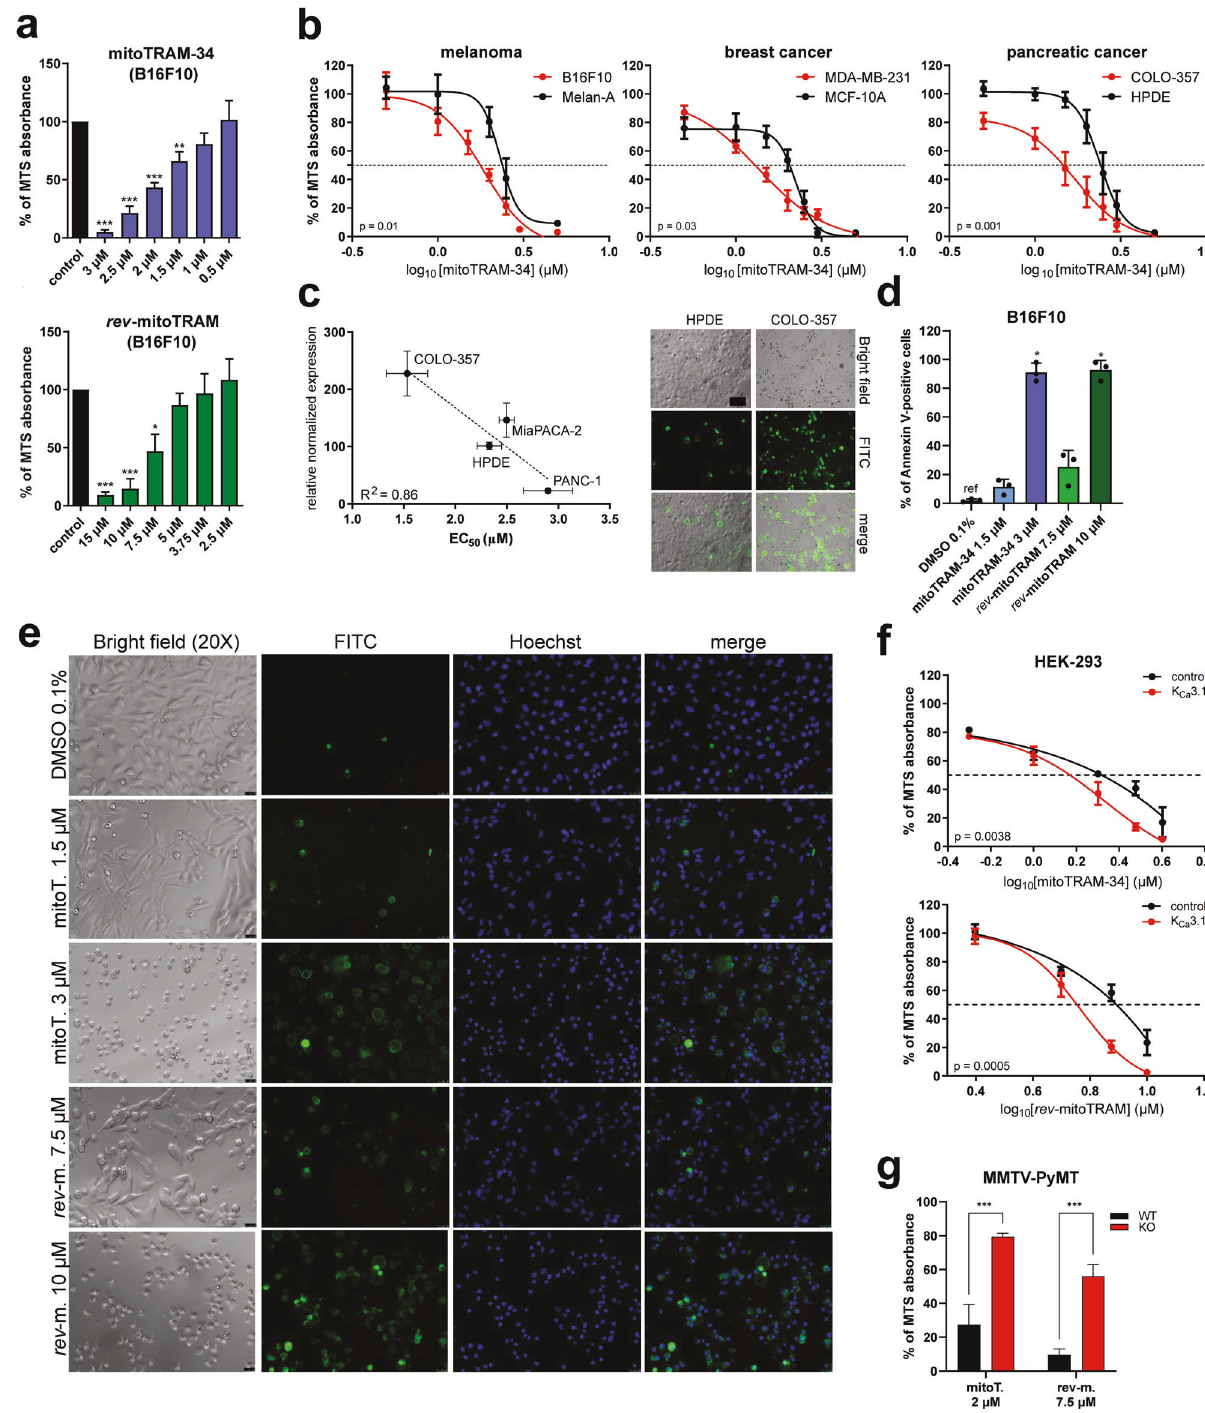
diffusion of TRAM-34-OH to other cellular compartments or outside the cell (Table 1). In agreement with this notion, TRAM- 34-OH (which is not selectively accumulated in mitochondria but freely diffuses) affected cell viability at much higher concentra- tions than rev -mitoTRAM (Fig. S3a). Neither TRAM-34 nor TPPP- NH 3 had any effect on cellular survival at the highest used dose (20 µM) (Fig. S3b). The lack of effect on cell viability by TRAM-34 is in agreement with previous studies (e.g., [24]). To con fi rm that the reduced MTS absorbance corresponds to cell death induction and Cell Death and Disease (2022)